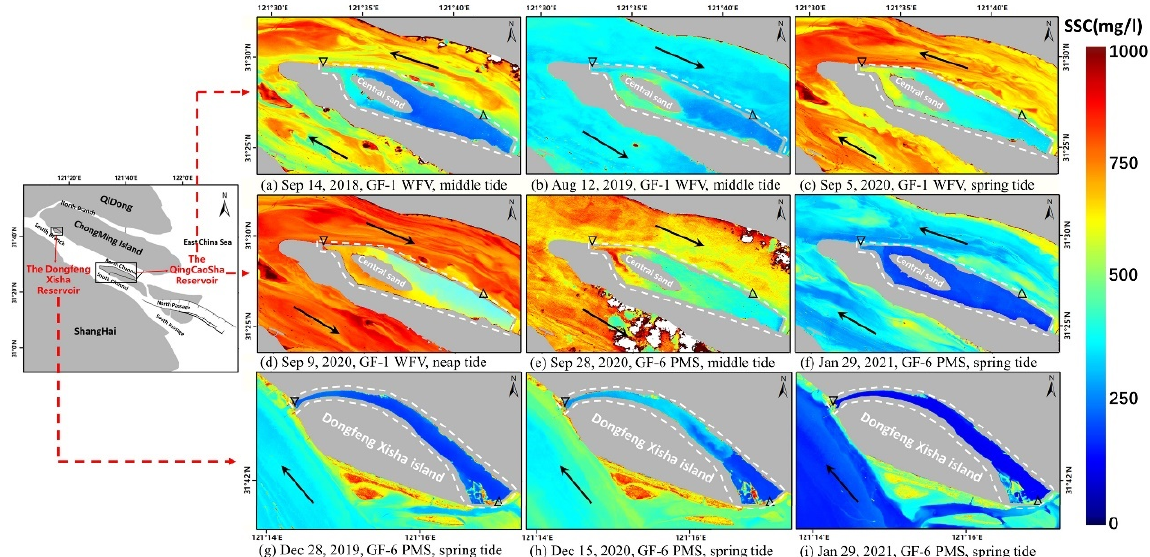
Figure 6. SSC in the Qingcaosha reservoir retrieved from the GF-1 WFV and GF-6 PMS images. Black inverted triangles: water inlet; black triangles: water outlet.